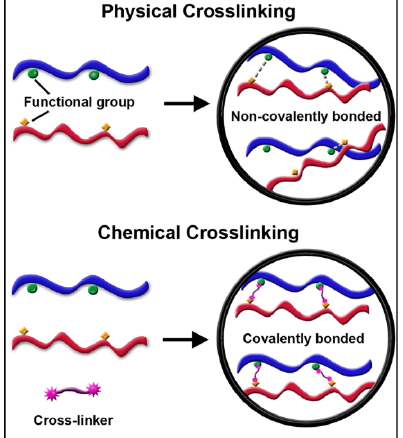
Figure 8. The difference between physical and chemical cross-linking [84].